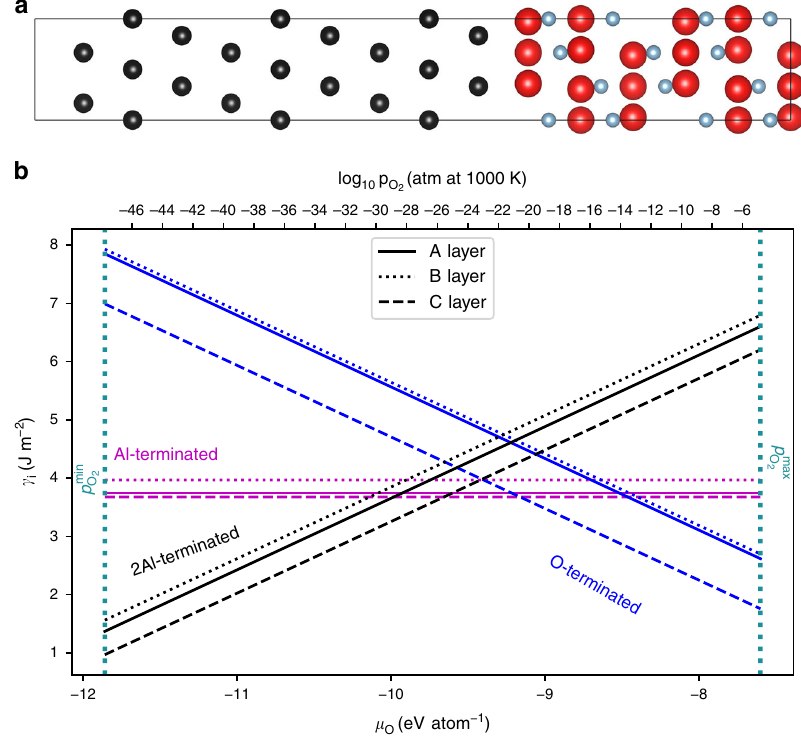
(cid:4) (cid:5) interface energy. a Unrelaxed, atomistic model of the (C-terminated) Ni/(O-terminated) Fig. 3 DFT prediction of the M1 Ni(111) 1 (cid:1) 10 ½ (cid:2) ||Al 2 O 3 (0001) 11 (cid:1) 20 sapphire interface. Ni, Al, and O are shown in black, blue and red. b Interface energy of the Ni/sapphire interface considering the three Ni translations (A, B, C) and the three sapphire terminations (2Al-terminated, Al-terminated, O-terminated shown in black, magenta, and blue, respectively) within the limits of p max and p min shown using dotted vertical teal O 2 O 2